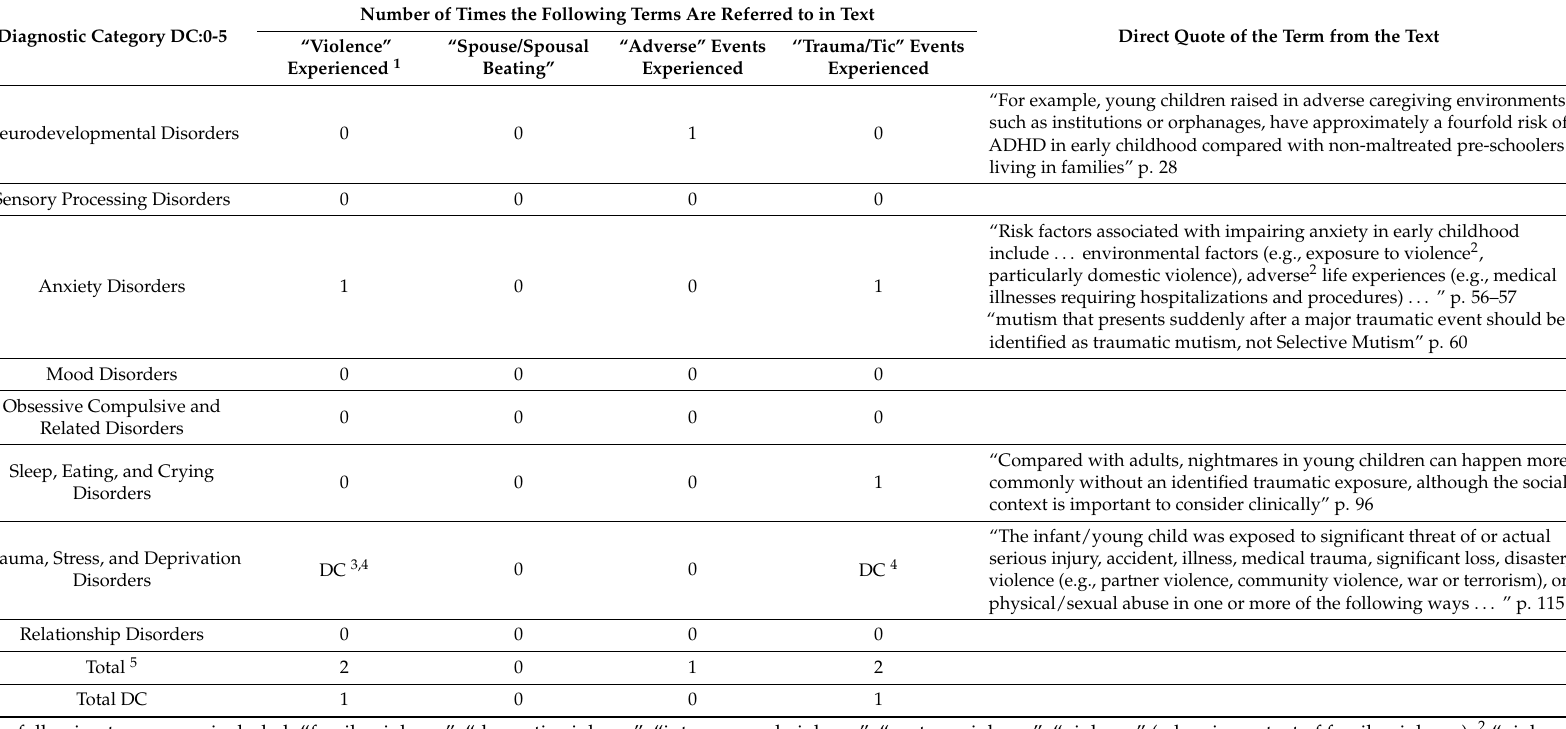
Table 3. Frequency of the terms “family violence”, “domestic violence”, “interpersonal violence”, “partner violence”, “violence”, “spouse/spousal beating”, “adverse” and “trauma/tic” in the context of family violence and events experienced or perpetrated in the DC:0-5 Axis I.